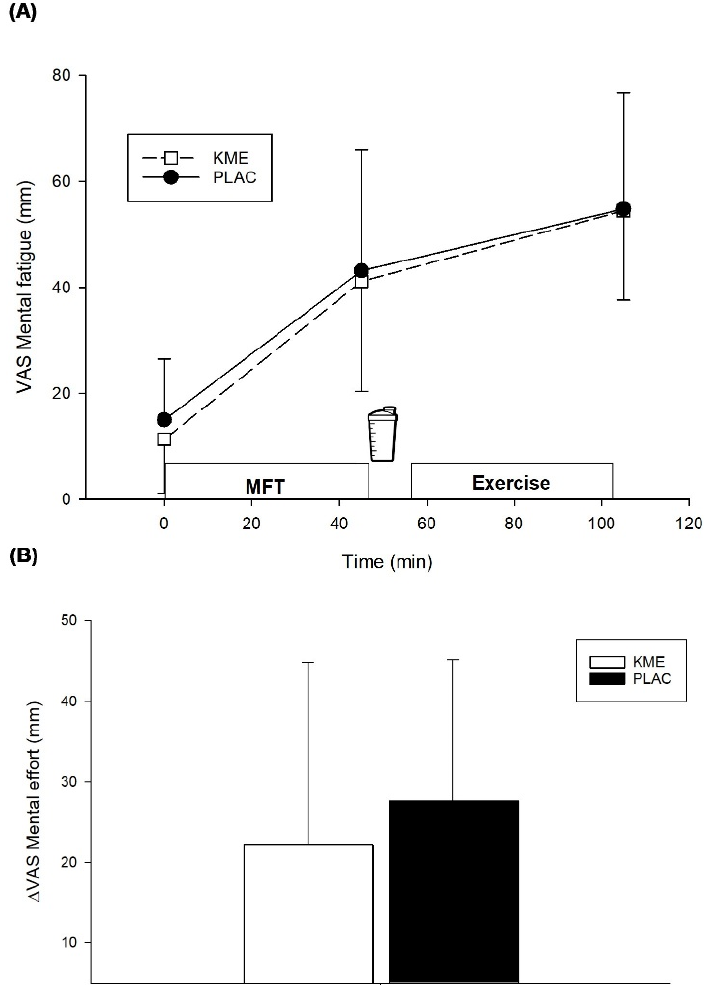
Figure 3. Effects of KME supplementation on subjective ratings of mental fatigue and mental effort ( A ) Subjective ratings of mental fatigue ( B ) difference in subjective ratings of mental effort, relative to pre-exercise (Post MFT). Values are means ± SD. MFT = mental fatiguing task; KME = ketone monoester supplement; PLAC = non-caloric placebo. VAS = Visual Analogue Scale. Table 1. Ratings of perceived exertion